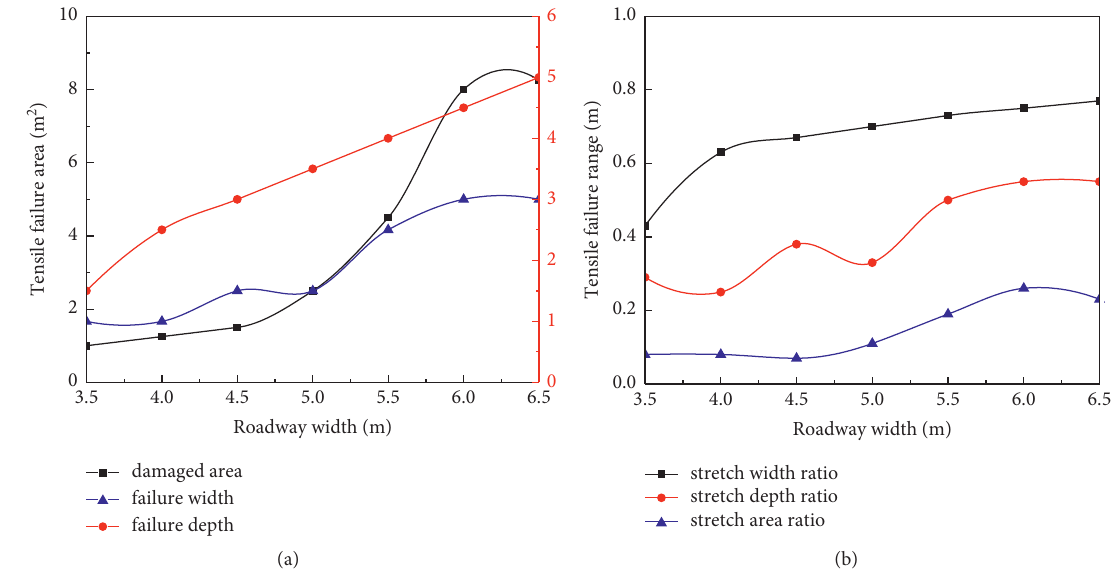
Figure 8: Influence of roadway width on roof damage degree. (a) Absolute value; (b)